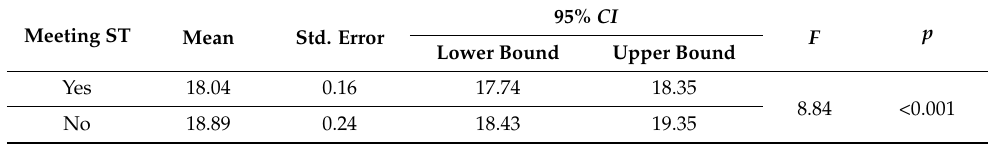
Table A4. Comparison of ST between overweight and obese and normal children and adolescents. Overweight and Obesity